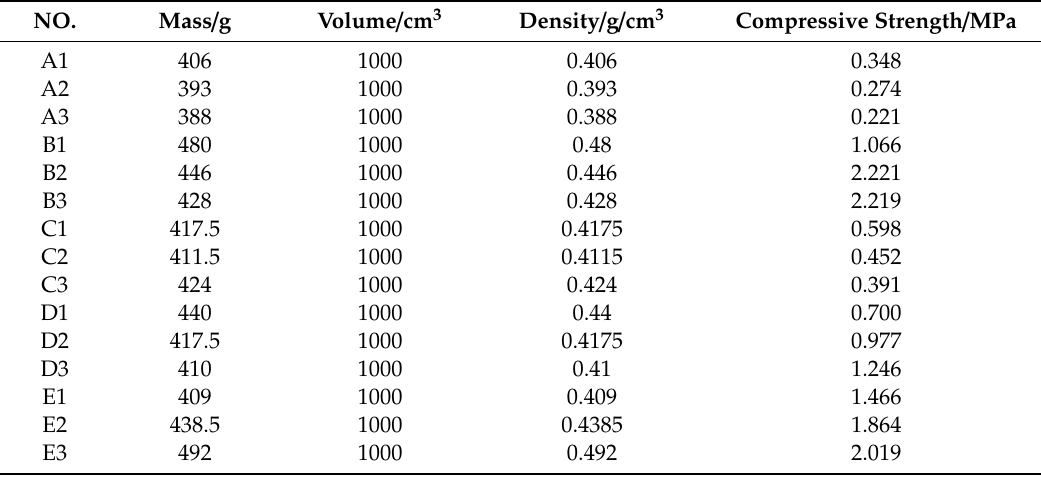
Table 2. Physical and mechanical parameters of the